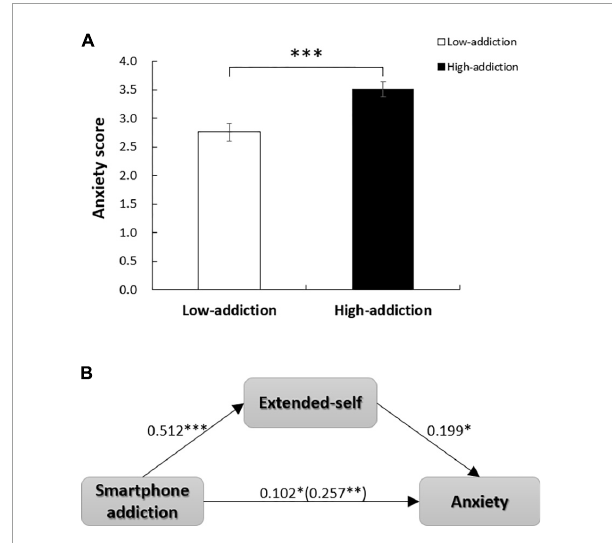
FIGURE7 (A) Participants in the high-addiction group represented higher anxiety than those in the low-addiction group ( p < 0.001). (B) Extended-self mediated the effects of smartphone addiction on anxiety. ∗ p < 0.05; ∗∗ p < 0.01; ∗∗∗ p <